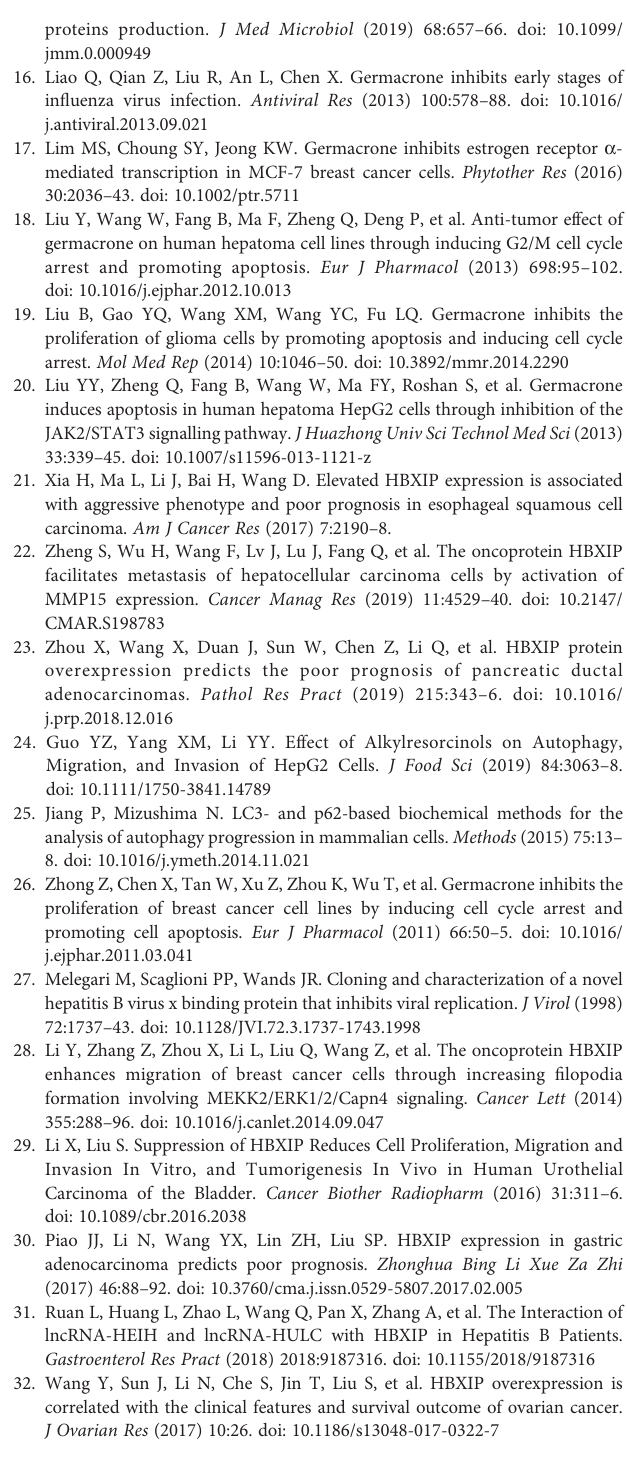
SUPPLEMENTARY FIGURE 1 | Germacrone regulated HBXIP transcription level. (A) After treatment of MGC803 cells with 100, 150, 200 m M germacrone, RT- PCR detected changes in HBXIP RNA levels. SUPPLEMENTARY FIGURE 2 | Knocked down HBXIP decreased cell proliferation. (A) Western blot experiments veri fi ed the knockdown effect of si-RNA.